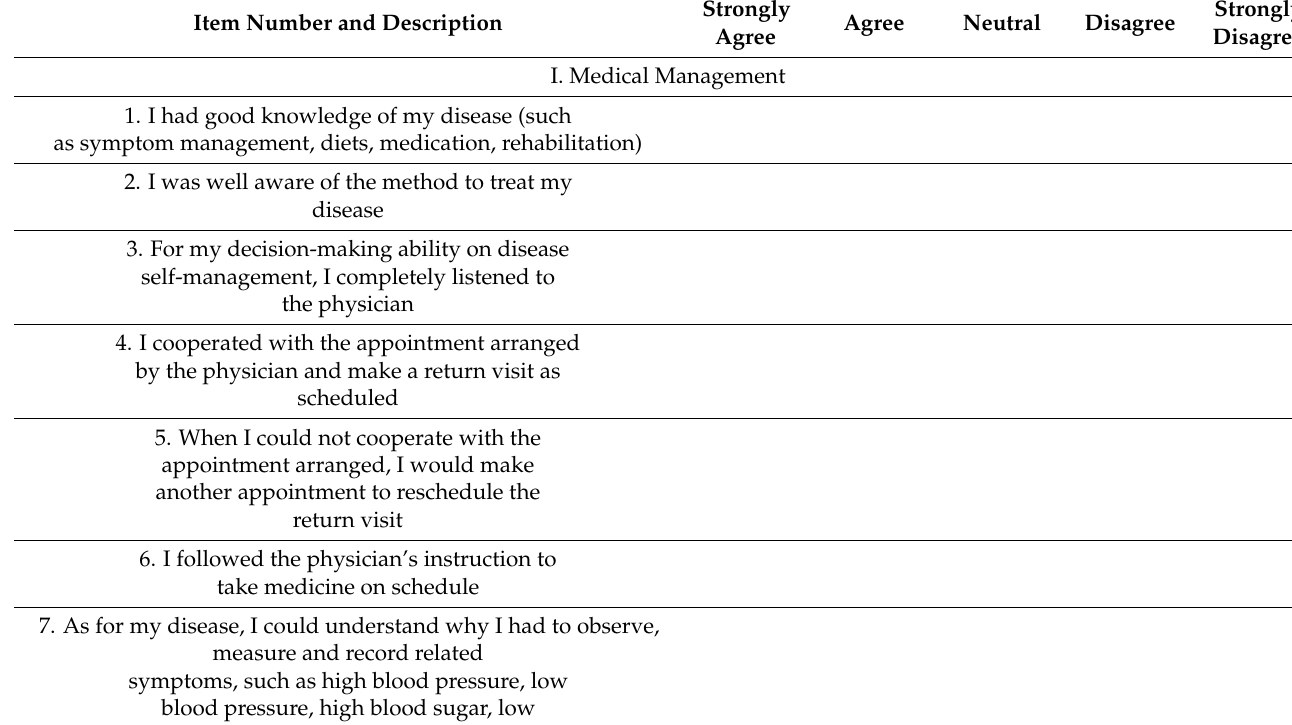
Table A2. The Stroke Self-Management